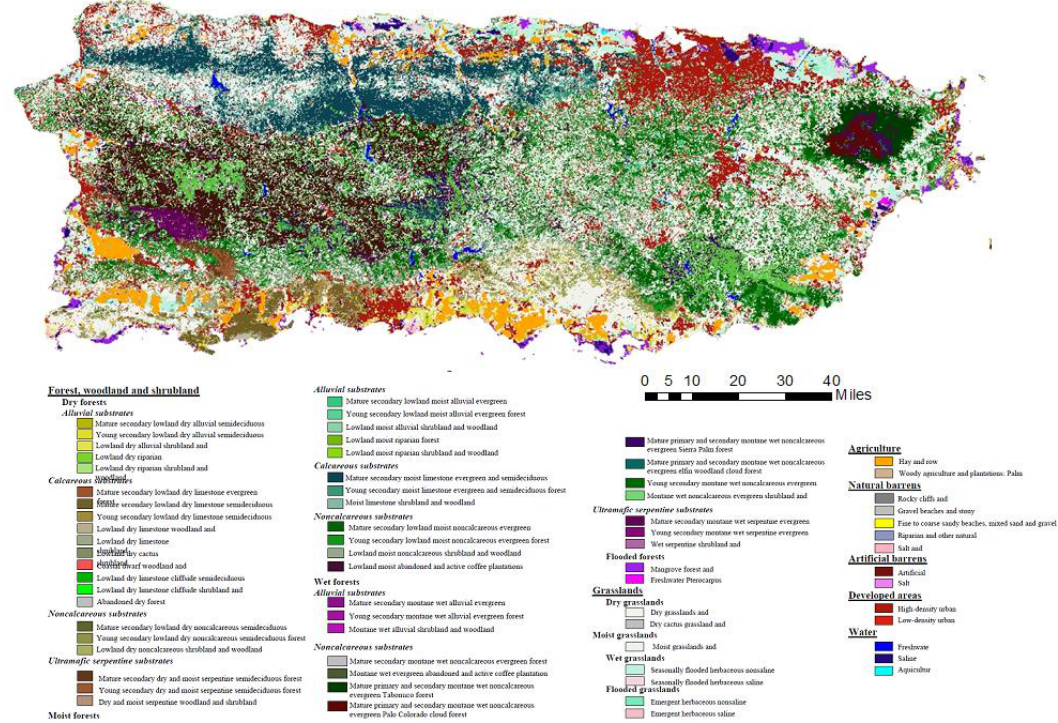
Table 3. Number of stations by Selection Type and Analyzed HELZ and Land Cover for the 1992 Puerto Rico Land Cover